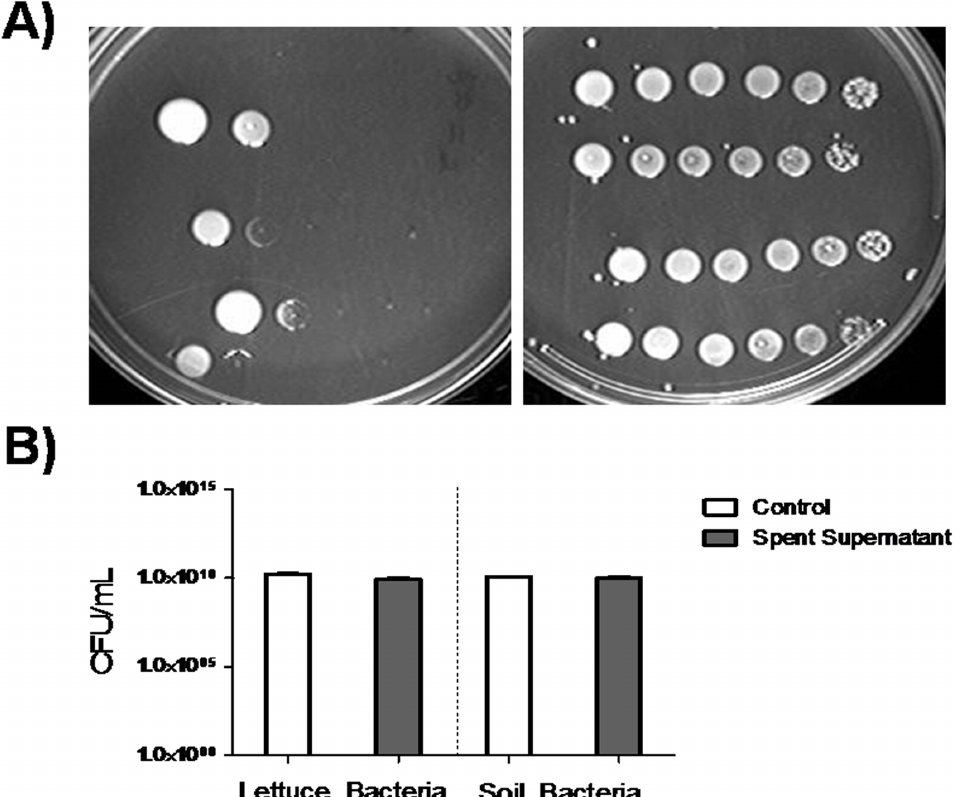
Fig. 1. F. tularensis spent medium enhances growth and is specific for F. tularensis . A) F. tularensis was cultured for 24 h and diluted on TSA containing 0.1% L-cysteine ( left ) and TSA containing 0.1% L-cysteine and 10% spent medium ( right ). A ten-fold dilution series of F. tularensis was created (10 2 1 –10 2 6 , left to right). B) Lettuce bacteria were obtained from stomacher processing of 10 g of lettuce in 50 mL of TSB containing 0.1% L-cysteine. Soil bacteria were obtained from culturing of 1 g of soil, hay and dust in TSB containing 0.1% L-cysteine overnight at 37 ˚ C with shaking at 120 rpm. Bacteria from lettuce and soil sources were diluted to 10 2 6 and plated on TSA supplemented with 0.1% L-cysteine (control) and control agar supplemented with 10% F. tularensis spent filtrate. Samples were incubated overnight at 37 ˚ C and the CFU/mL was calculated. Legend: Control 5 white bar, Spent filtrate 5 medium grey